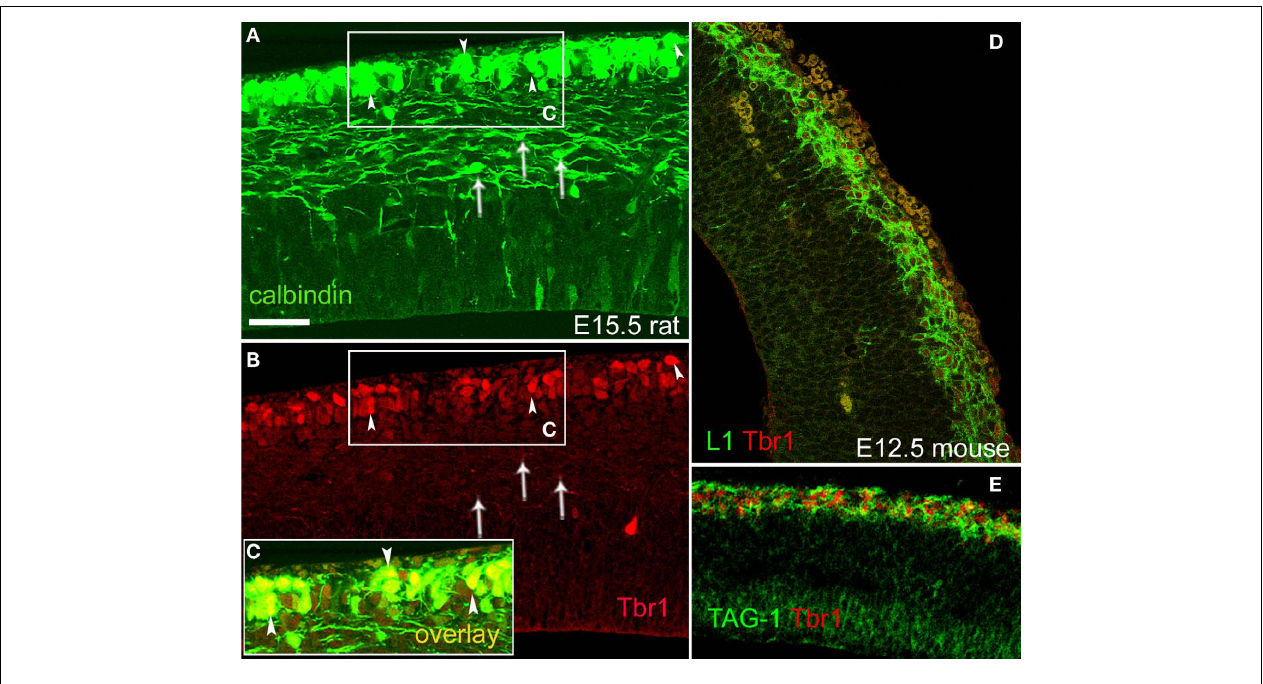
FIGURE 8 | Pioneer neurons in the preplate co-expressed Tbr1 in rats and mice. (A–C) CB + preplate cells co-expressed Tbr1; E15.5 rat. Arrowheads signal co-labeled cells. Overlay is shown in the boxed area (C) . CB + cells in the intermediate zone (arrows), possibly migrating interneurons,